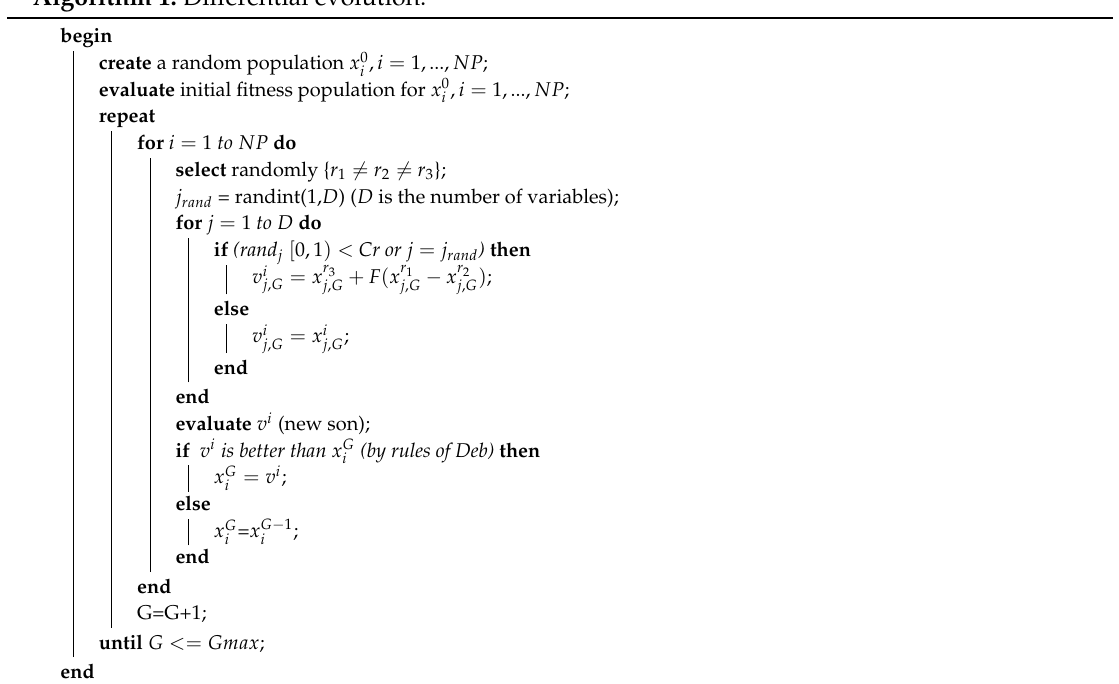
Algorithm 1: Differential